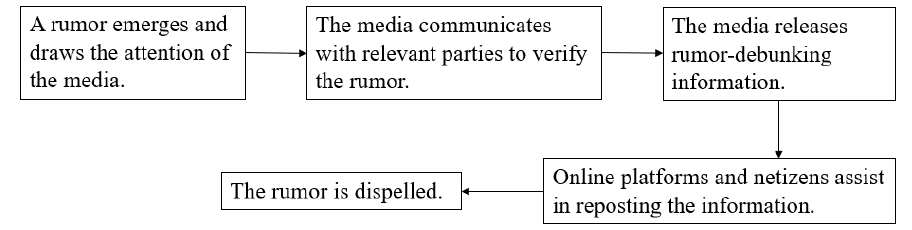
Figure 2. The “media-led” rumor-debunking Figure 2. The “ media- led” rumor -debunking model.